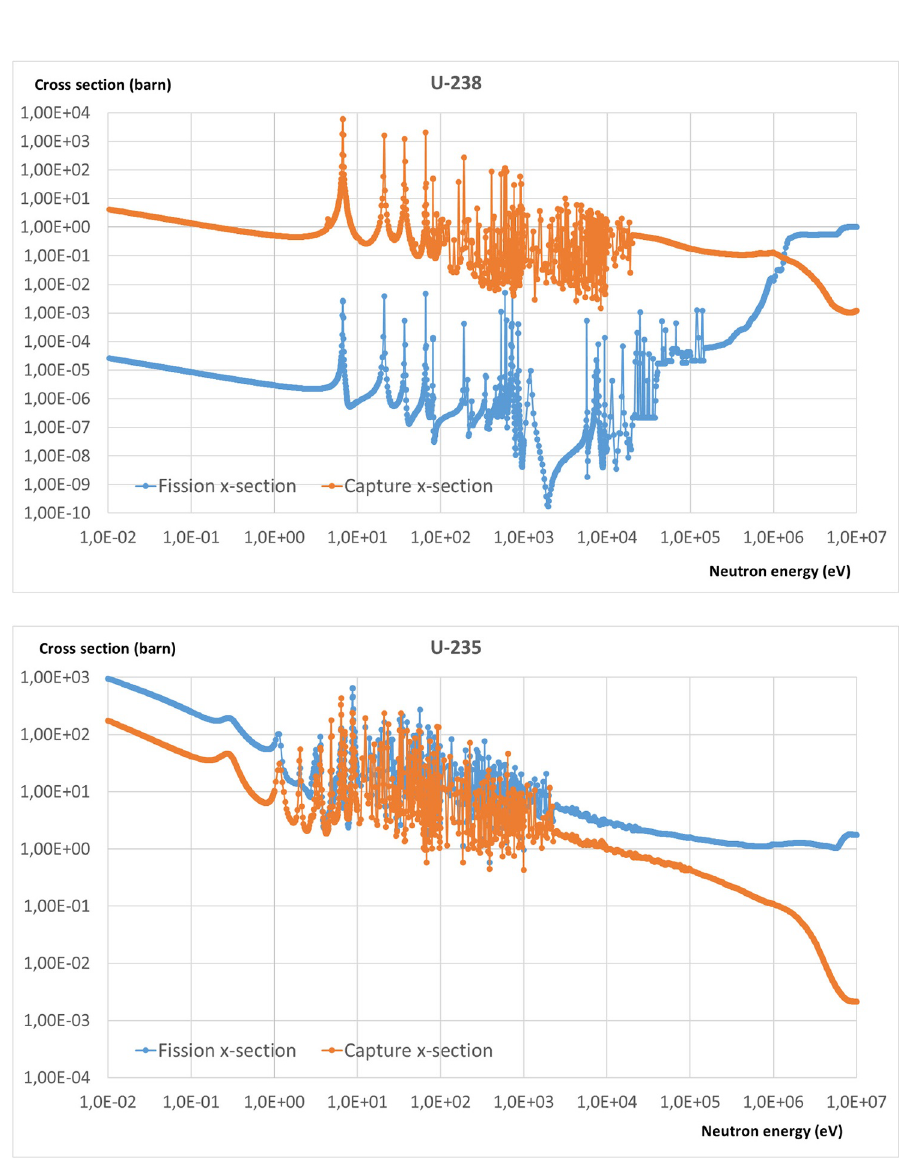
Fig. 3. – Fission (blue) and radiative capture (red) cross sections for the two isotopes of uranium.